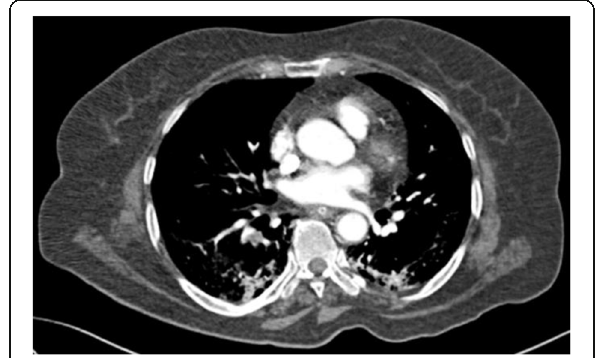
Fig. 4 CT pulmonary angiogram showing bilateral small peripheral pulmonary emboli